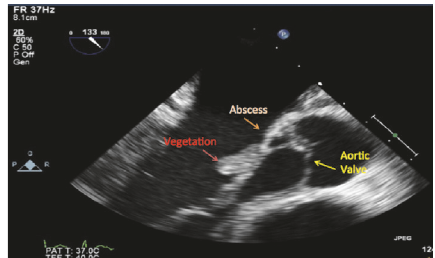
Figure 4: Doppler confirming an abnormal flow tract from the aorta.